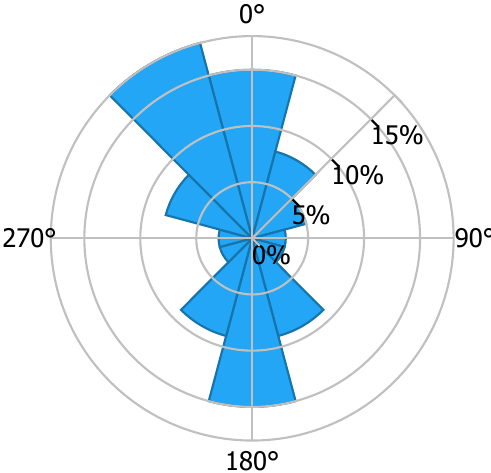
Figure 6. Global Wind Atlas: Wind Speed Rose at site.